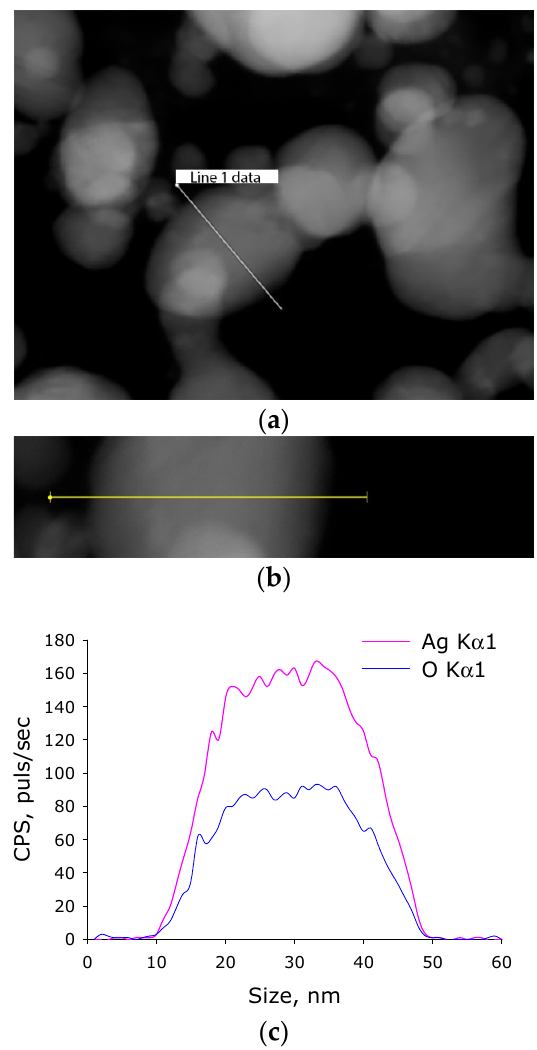
Figure 4. Elemental analysis of of silver oxide NPs. ( a ) TEM image of group of silver oxide NPs; analysis section is indicated by line 1. ( b ) Enlarged measurement site. ( c ) Nanoparticle profile by Ag K α 1 and O K α 1.